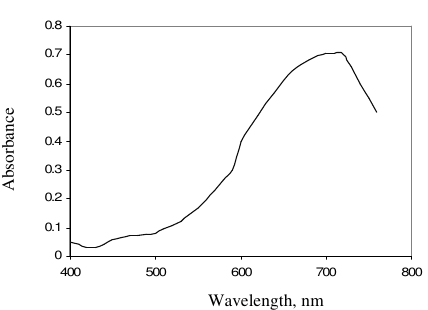
Figure 1. Absorption spectra of paracetamol by proposed method